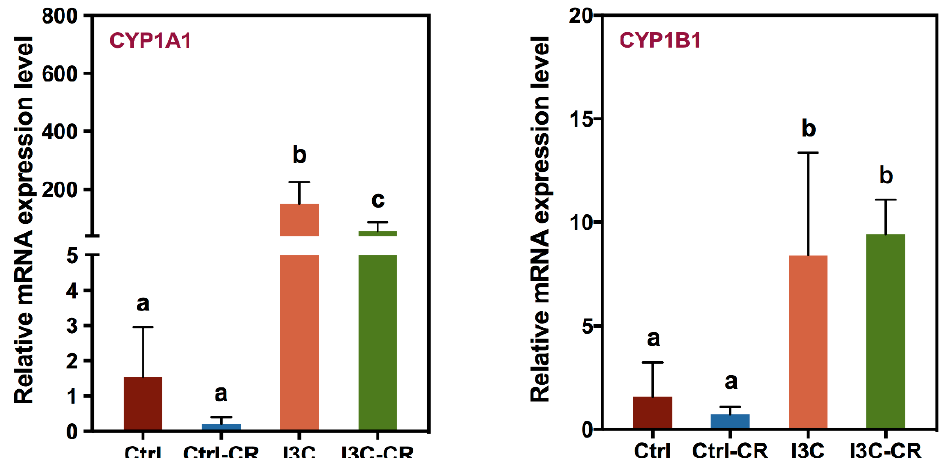
Figure 4. Xenobiotic metabolizing enzyme genes were upregulated in colons of mice fed the I3C diet. Total RNA isolated from colon tissues were harvested on day 12 after infection. The expression of cytochrome P450 1A1 (CYP1A1) and 1B1 (CYP1B1) enzyme genes were determined by using real-timeRT-PCR. Results were expressed as mean +/ − SD ( n = 8). Di ff erent letters indicated significant di ff erences between groups for each tissue ( p < 0.05).